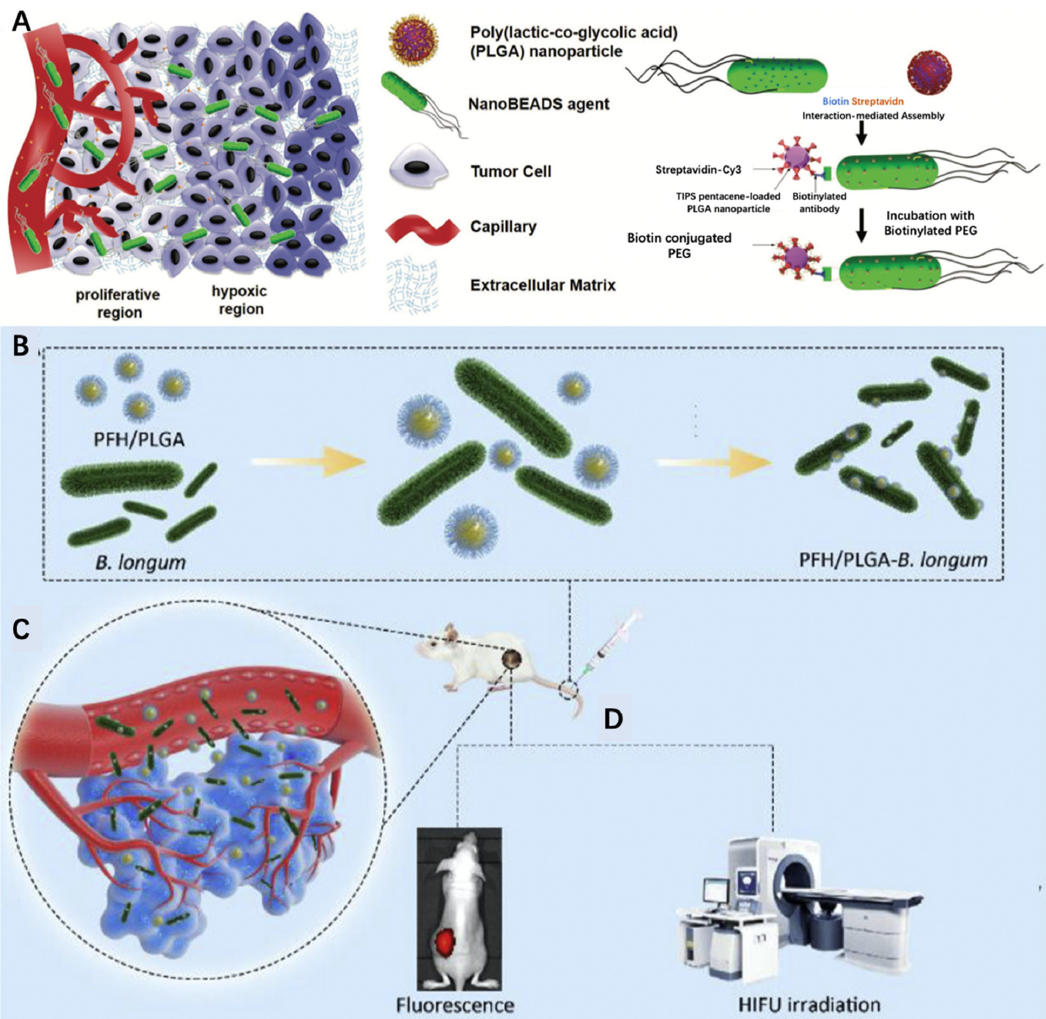
Figure 4. ( A ) Schematic illustrating enhanced penetration of NanoBEADS in a poorly vascularized tumor tissue compared with passively diffusing nanoparticles. Reproduced with permission [78], 2018, Wiley-VCH GmbH, Weinheim. ( B ) Synthesis of PFH/PLGA– Bifidobacterium longum . ( C ) Targeting the tumor tissue. ( D ) Fluorescence imaging and HIFU therapy. Reproduced with permission [79], 2019, Elsevier.